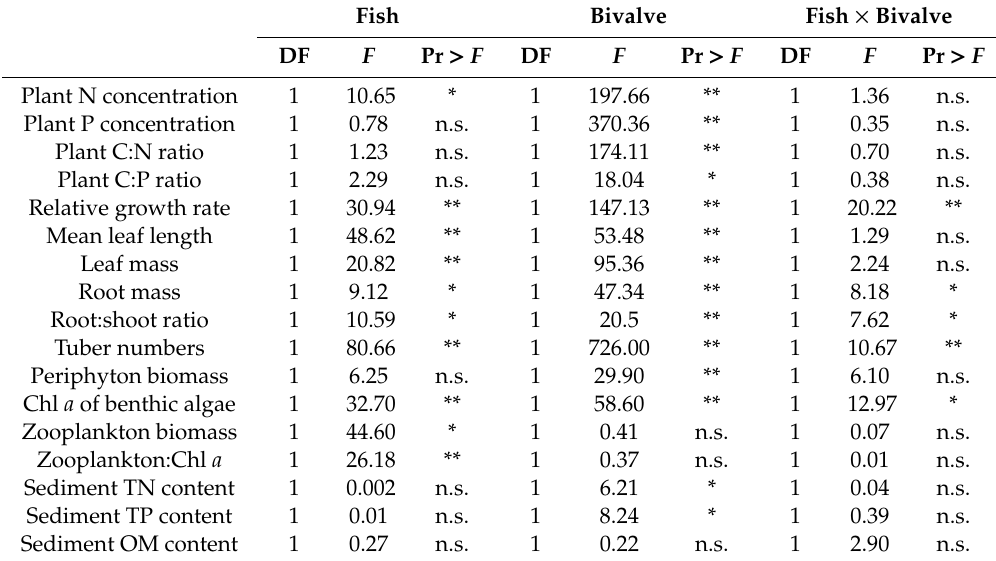
Periphyton biomass